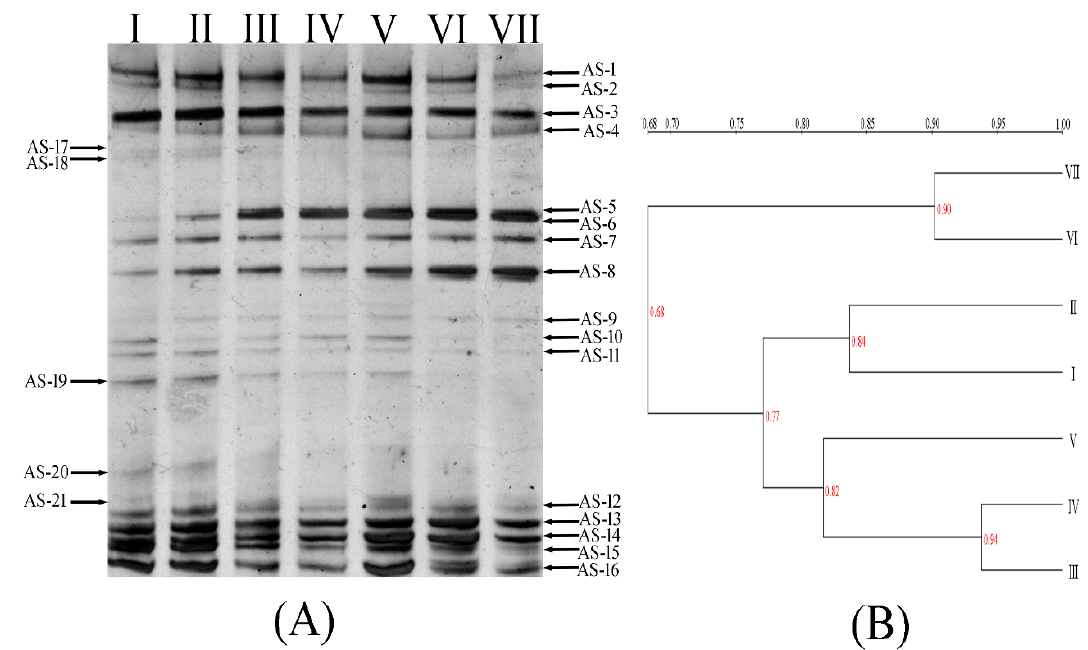
Figure 4. DGGE fingerprints of microbial communities ( A ) and cluster analysis based on “UPGMA” method ( B ) in the samples at different stages of the anaerobic system running. Lane designations: I: original microbial community; II: microbial samples for continuously decolorizing 50 mg·L − 1 of three model dyes (Methyl Orange, Reactive Blue 19 and Malachite Green) after 10 days; III: microbial samples for continuously decolorizing 100 mg·L − 1 of three model dyes after 10 days; IV: microbial samples for continuously decolorizing 150 mg·L − 1 of three model dyes after 10 days; V: microbial samples for continuously decolorizing 200 mg·L − 1 of three model dyes after 10 days; VI: microbial samples for continuously decolorizing 250 mg·L − 1 of three model dyes after 10 days; VII: microbial samples for continuously decolorizing 300 mg·L − 1 of three model dyes after 10 days.